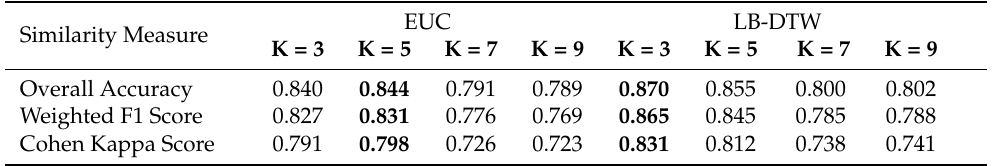
Table 6. Comparison of different K values for the second SITS